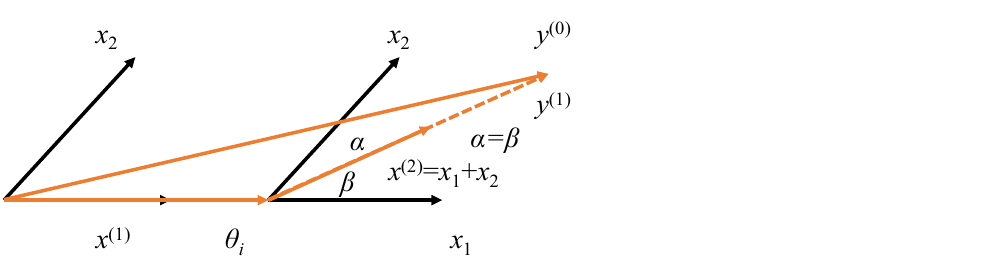
Figure 3. The two-dimensional diagram of LAR